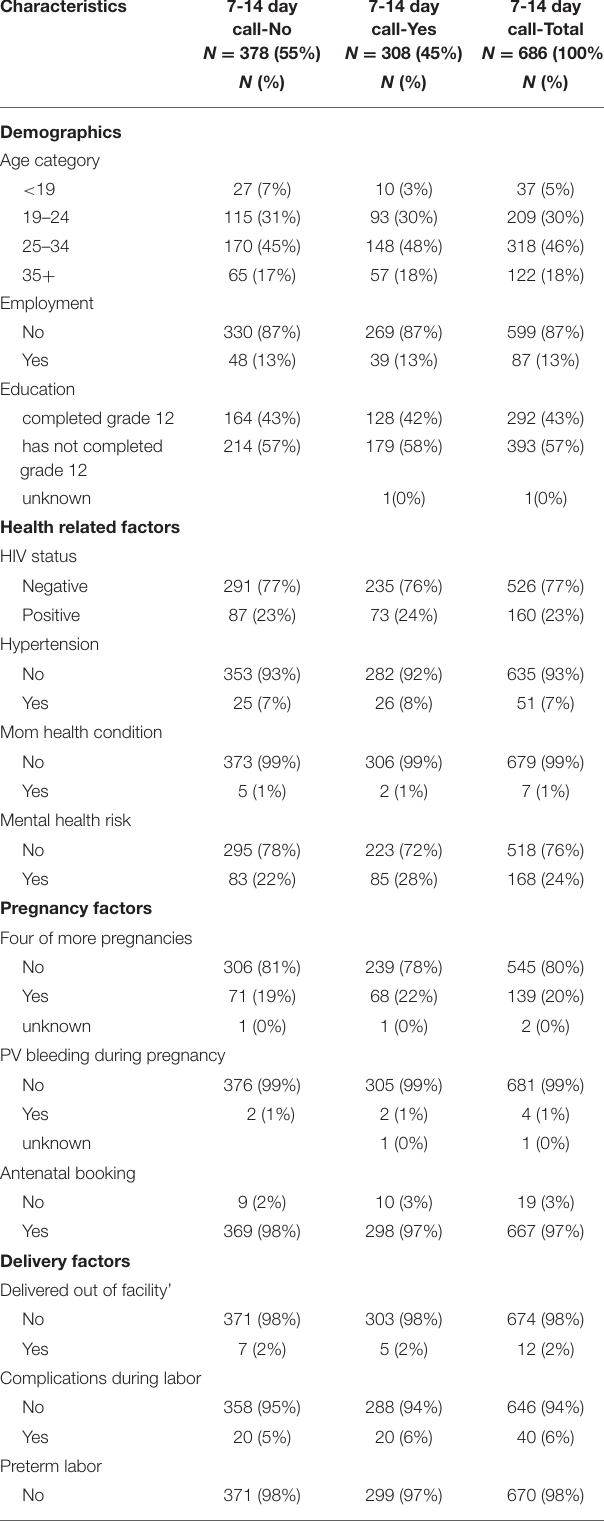
TABLE 1 | Characteristics of MIP who received and did not receive the 7–14-day call.